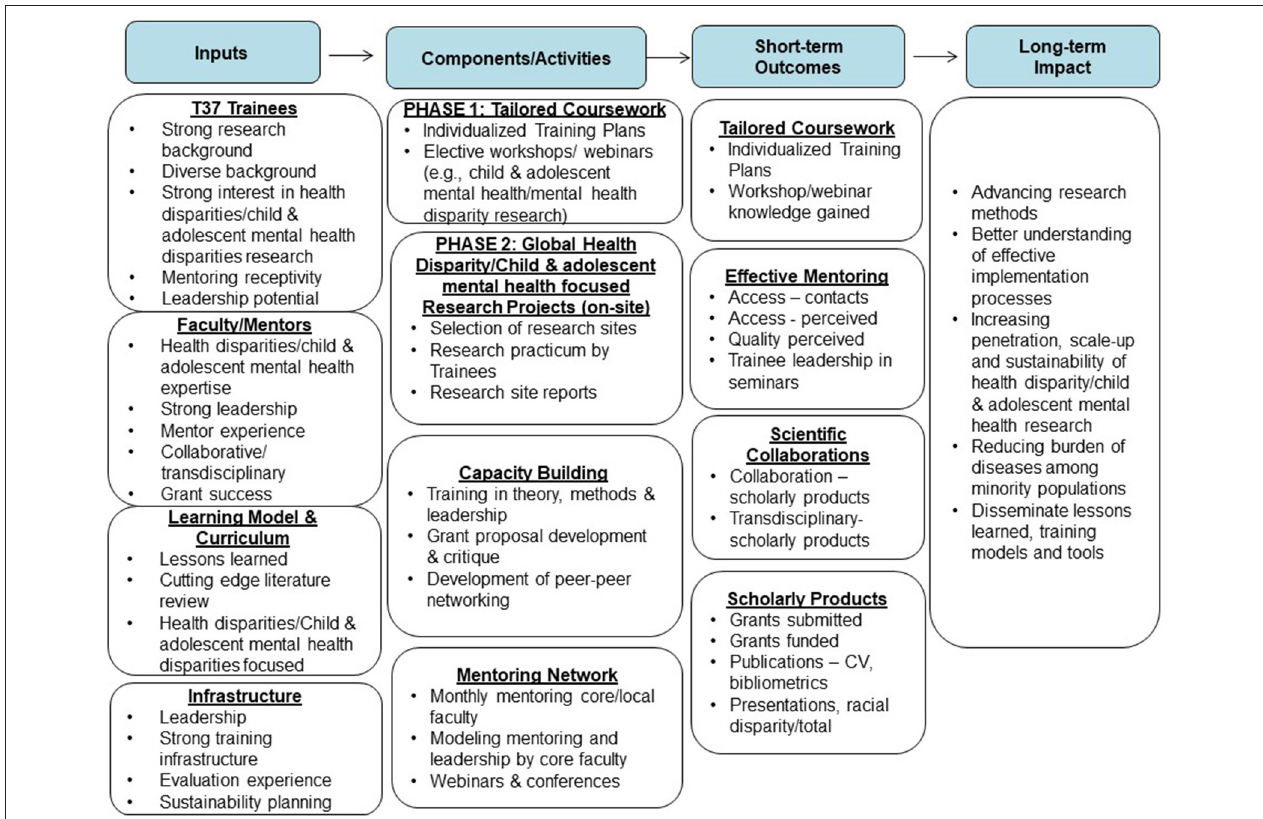
FIGURE 2 | LEAD Program Logic